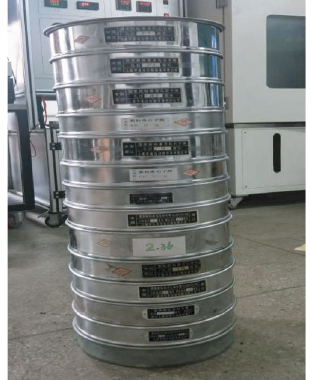
Figure 1: Vibration classi fi cation